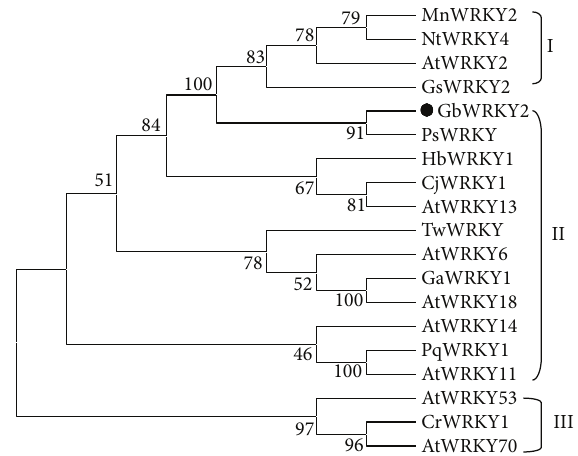
Figure 7: Phylogenetic tree of the sequences of GbWRKY2 and other plants WRKY protein. The numbers at each node represented the bootstrap values (with 1000 replicates). The GenBank accession numbers of WRKY proteins and translation of their names are shown as follows: GbWRKY2: Ginkgo biloba ; MnWRKY2: Morus